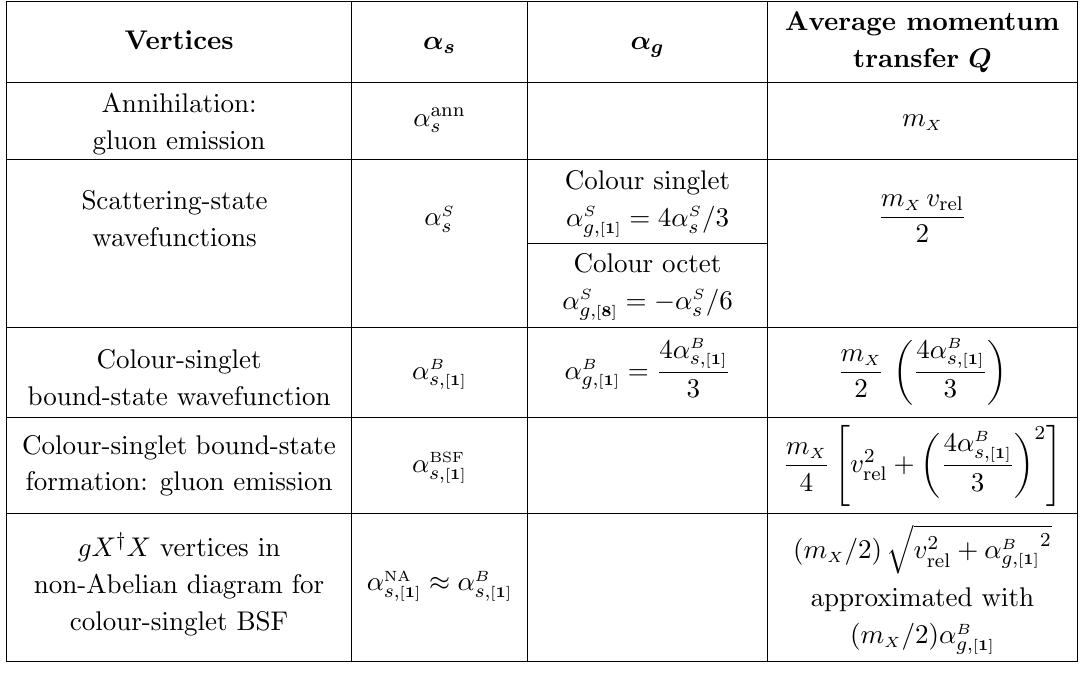
Table 2. The momentum transfer Q at which the strong coupling (cid:11) s ( Q ) is evaluated, for the various processes and the states participating in these processes, in the model of section